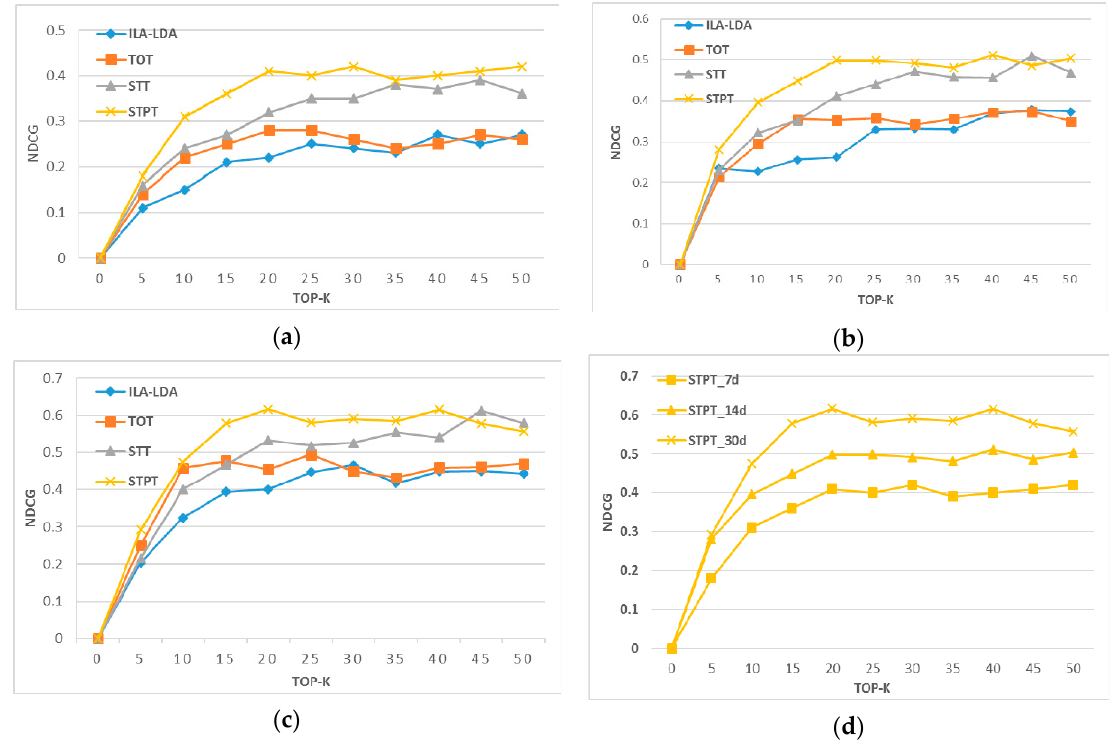
Figure 9. NDCGs of Top-k recommendation. ( a ) 7 days (time slice). ( b ) 14 days (time slice). ( c ) 30 days (time slice). ( d ) NDCG of STPT with different time slice.